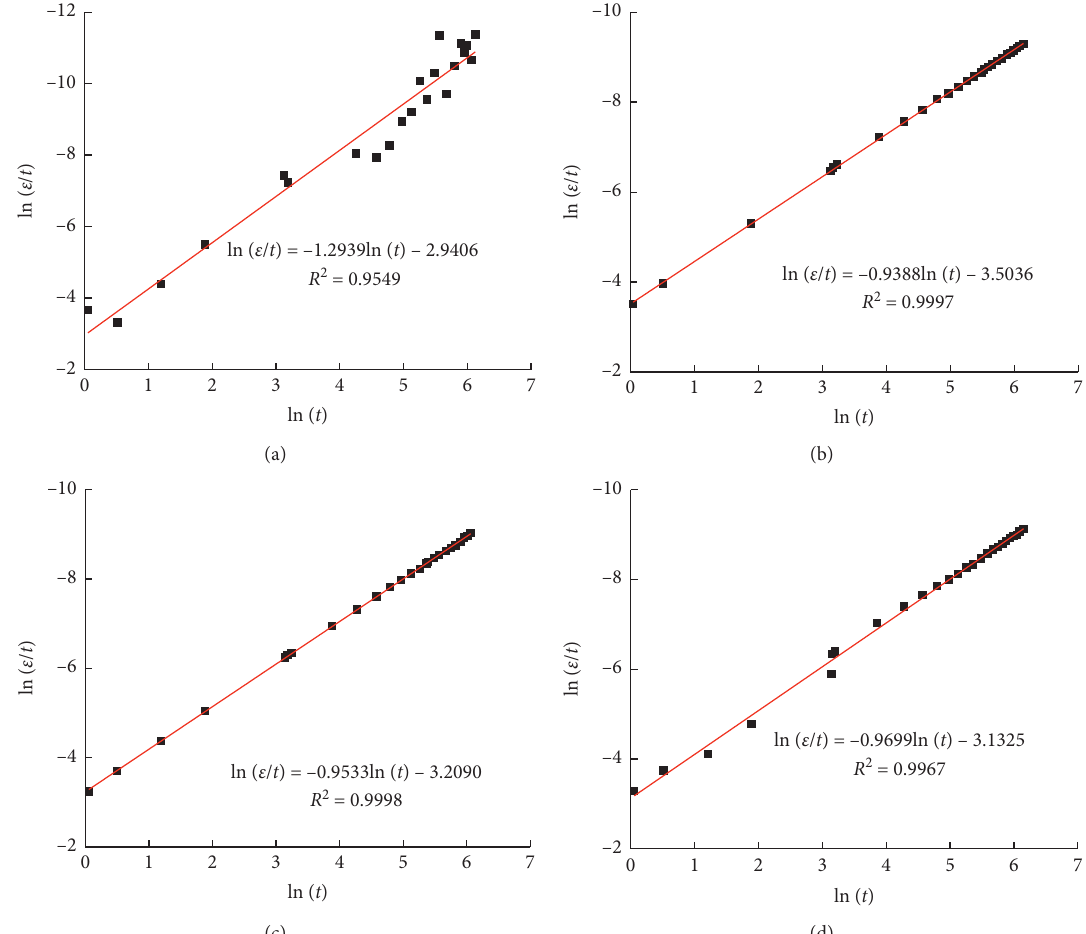
Figure 9: ln ( ε / t ) − ln ( t ) curve at E � 2169.0kJ/m 3 . (a) Vertical stress σ � 500kPa. (b) Vertical stress σ � 1000kPa. (c) Vertical stress 3 σ � 1500kPa. (d) Vertical stress σ �